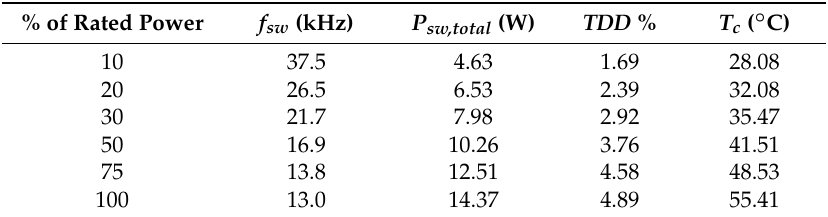
Table 2. Algorithm response to load